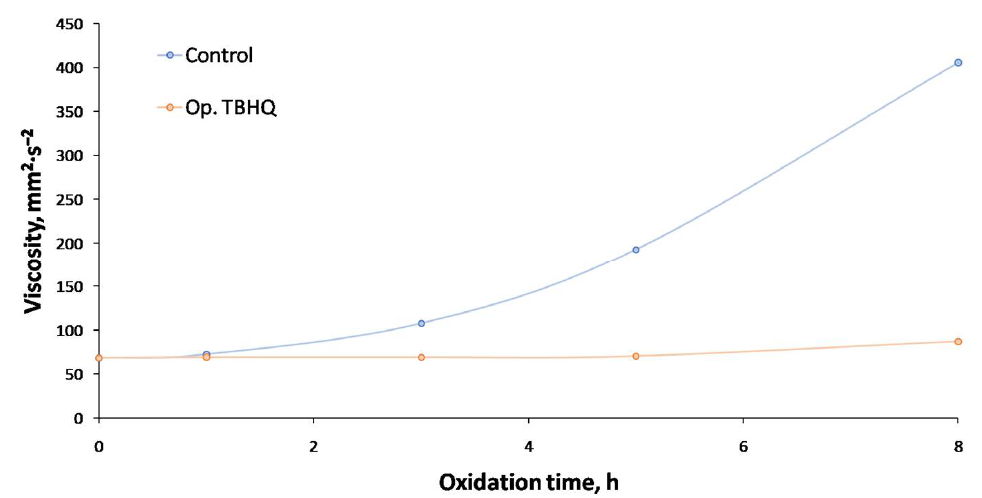
Figure 12. Effect of TBHQ addition on FOBL viscosity during oxidation.